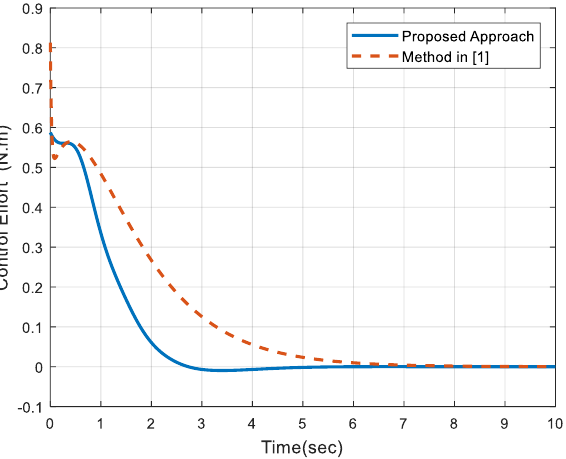
Figure 4. Controller effort of the suggested approach in comparison to the method applied in [1] .